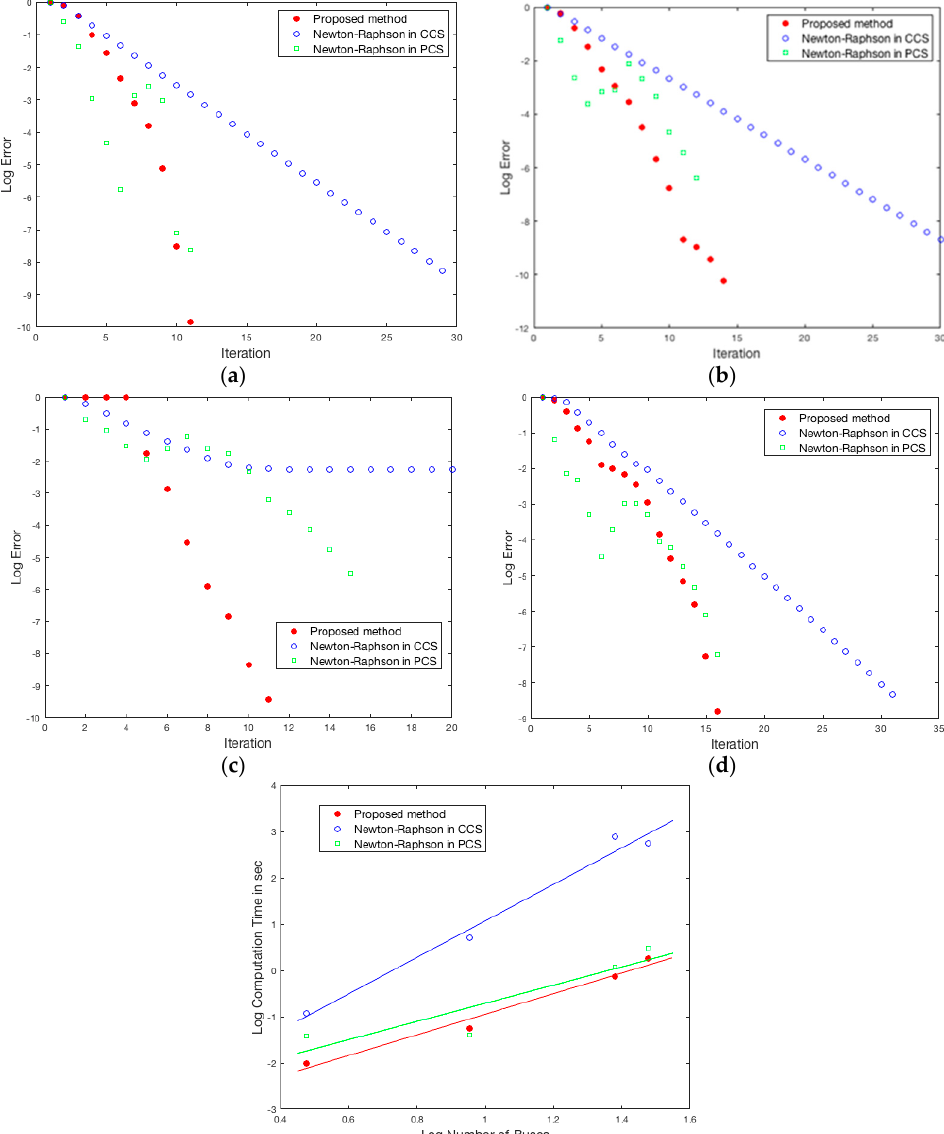
Figure 4. Performances of the Newton ‐ Raphson method formulated in the polar coordinate system (PCS) (green square), of the Newton ‐ Raphson method formulated in the Cartesian coordinate system (CCS; blue circle), and of the proposed method (red circle) for IEEE model systems; 3 ‐ bus ( a ); 9 ‐ bus ( b ); 24 ‐ bus ( c ); and 30 ‐ bus systems ( d ); as well as the computation times of the algorithms ( e ).